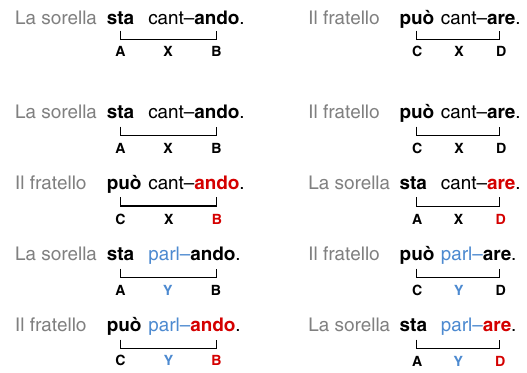
Fig.1 |Experimentaldesign. Intheencodingphase, verbphrasesof theformAXB and CXD with fi xed nonadjacent structure A – B and C – D and varying intermediate verbstems X were presentedinshortsentences. In the memorytest phase, infants wereexposedto:(1)regularsentenceswiththesamenonadjacentstructureandthe same old verb stems as in the encoding phase (AXB, CXD), (2) sentences with irregular structure, which violated the familiarised regularities, but contained the